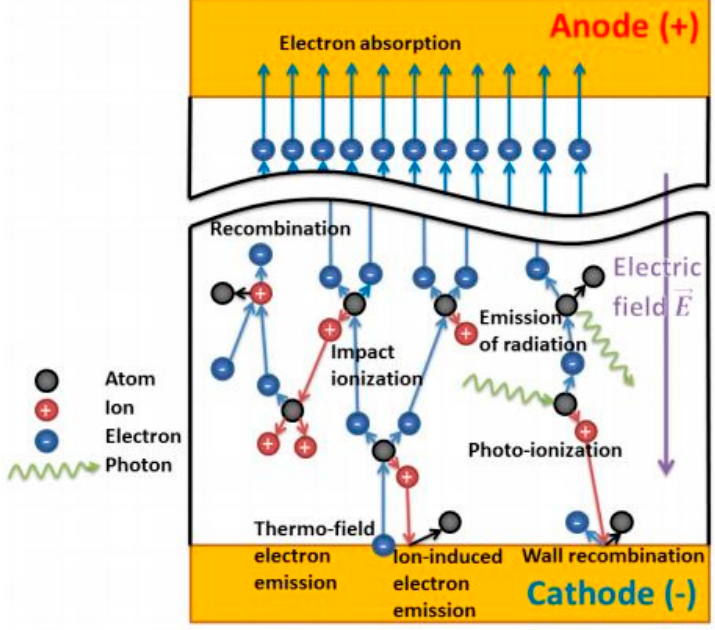
Figure 1. Schematics of the main processes involving electrons and ions which occur during spark discharge. From (Voloshko, 2015) (Image taken from: Andrey Voloshko. Nanoparticle formation by means of spark discharge at atmospheric pressure. Plasma Physics [physics.plasm-ph]. Université Jean Monnet—Saint-Etienne, 2015. English).